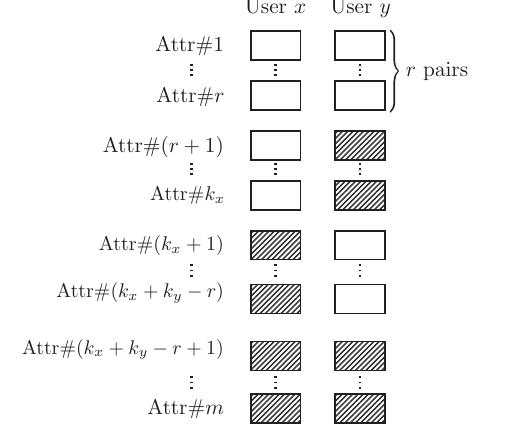
and k attributes respectively x y